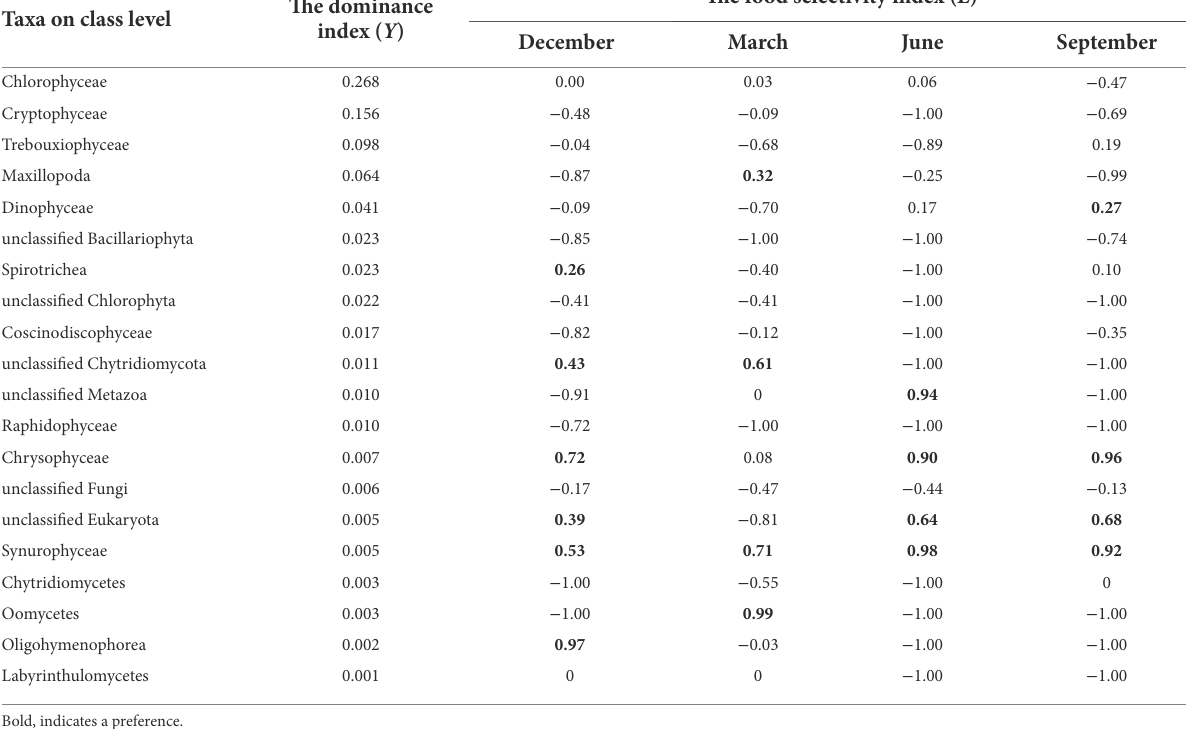
TABLE 1 The food selectivity index ( E ) of Polyarthra on eukaryotes on class level (top 20).